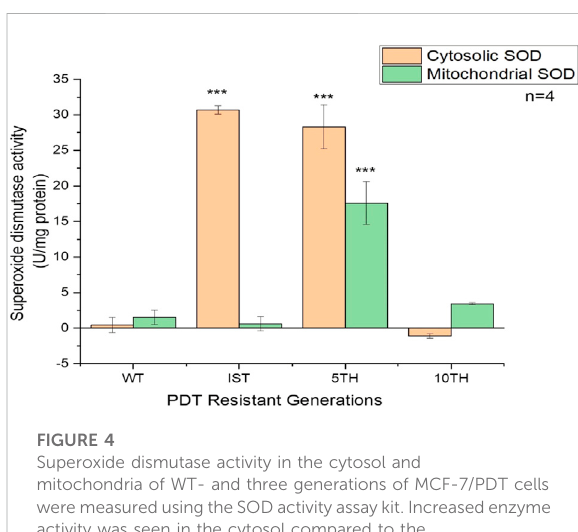
FIGURE 4 Superoxide dismutase activity in the cytosol and mitochondria of WT- and three generations of MCF-7/PDT cells were measured using theSOD activity assay kit. Increased enzyme activity was seen in the cytosol compared to the mitochondria. Signi fi cant differences were presented as * p < 0.05, ** p < 0.01, and *** p <